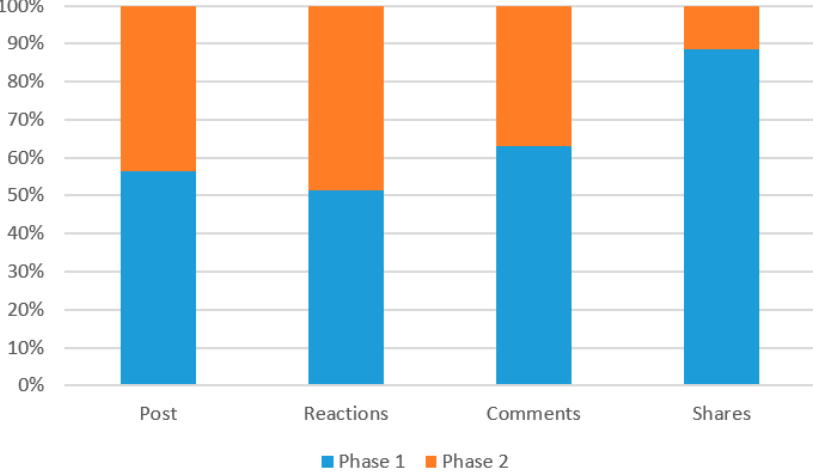
Table 2. Total of interactions for each phase.